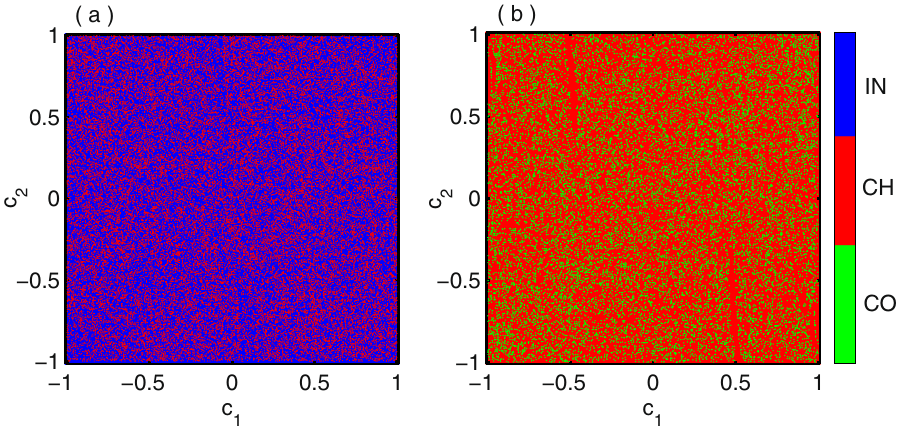
Figure 4. Basin of attractions for nonlocally coupled Mackey-Glass systems: ( a ) coexistence of incoherent and chimera states,  = . 0 33 , ( b ) coexistence of chimera and coherent states for = . 0 63  . Here IN, CH and CO stands for incoherent, chimera and coherent states